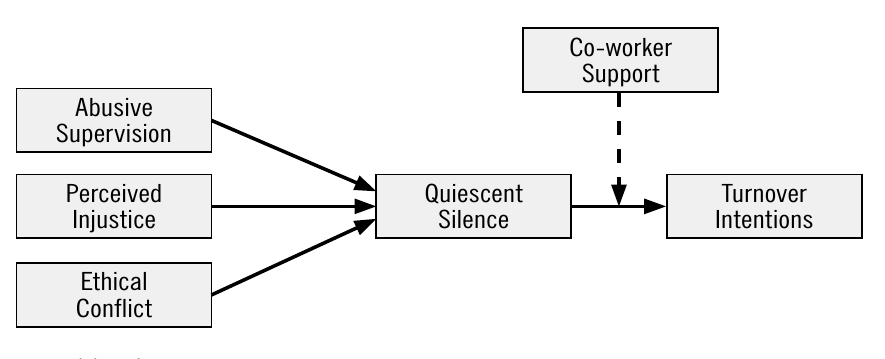
Figure 1. Theoretical